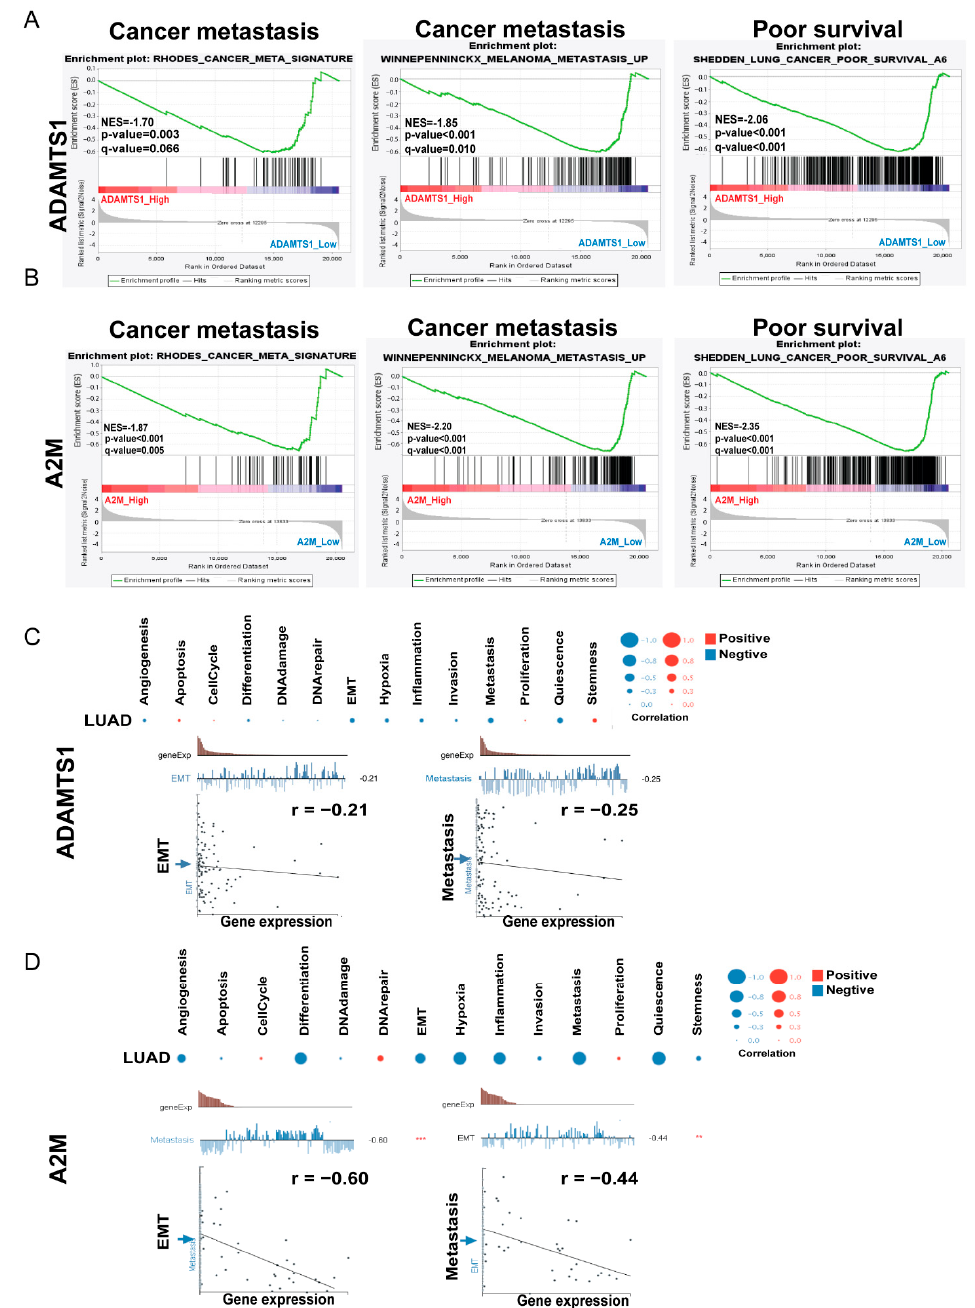
Figure 5. Functional states associated with ADAMTS1 and A2M . ( A ) Functional analyses of cancer metastasis and poor survival via gene set enrichment analysis (GSEA) in TCGA LUAD patients with high or low ADAMTS1 levels ( p < 0.05). ( B ) Functional analyses of cancer metastasis and poor survival via GSEA analysis in TCGA LUAD patients with high or low A2M levels ( p < 0.05). ( C ) The analysis of functional states of ADAMTS1 using CancerSEA. ( p < 0.05). ( D ) The analysis of functional states of A2M using CancerSEA ( p < 0.05). NES, normalized enrichment score. ** p < 0.01, *** p <